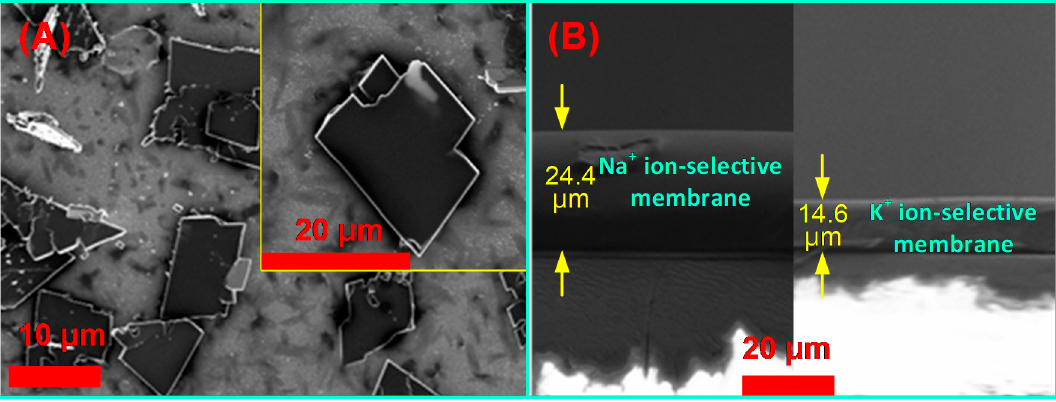
Figure 3. Scanning electron microscopy (SEM) images of electrode surface: ( A ) TCNQ/ion-selective membrane (ISM) deposited electrode (top view); ( B ) cross-sectional view.